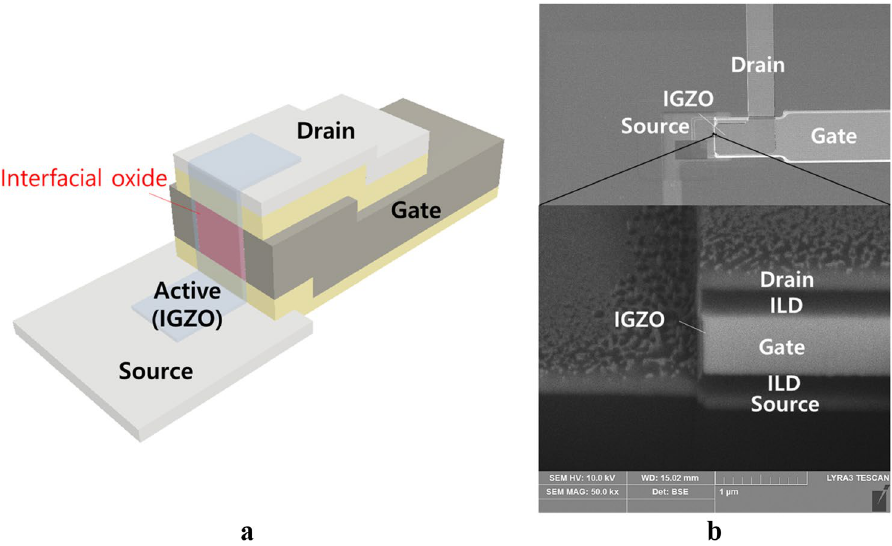
Figure 1. ( a ) Structure of the developed vertical-structure TFT. ( b ) SEM images of plane view and cross- sectional